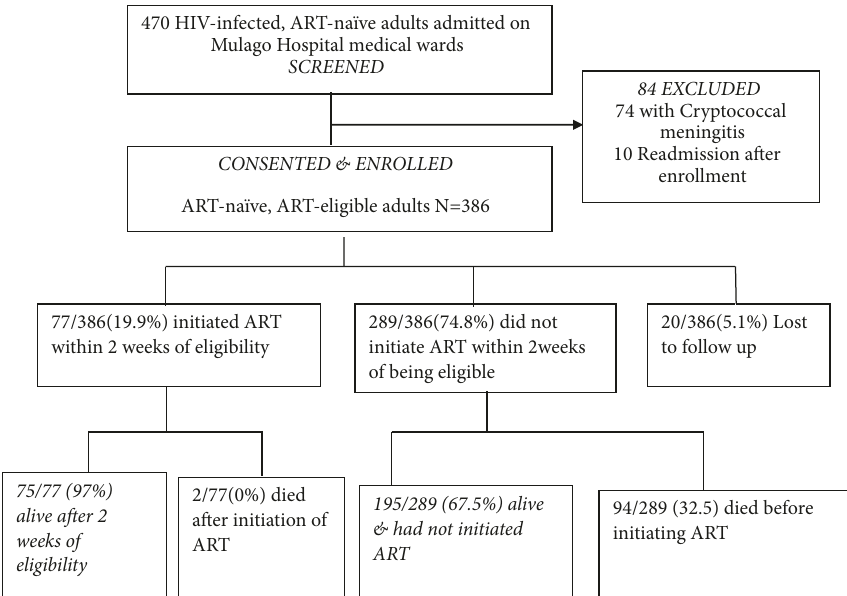
Figure 1: Study profile of HIV-infected adults hospitalized on medical ward at Mulago in December 2012-March